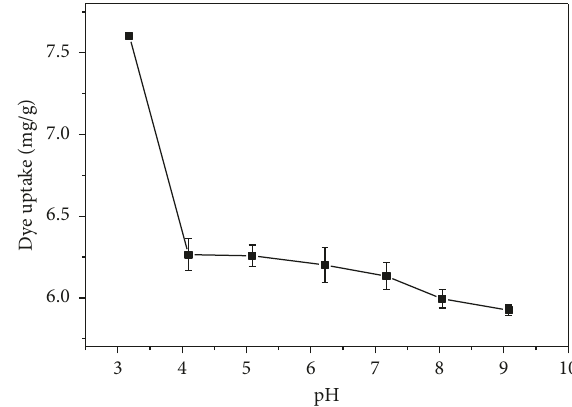
0 : 52.6mg/L, T: 30 ° C, and